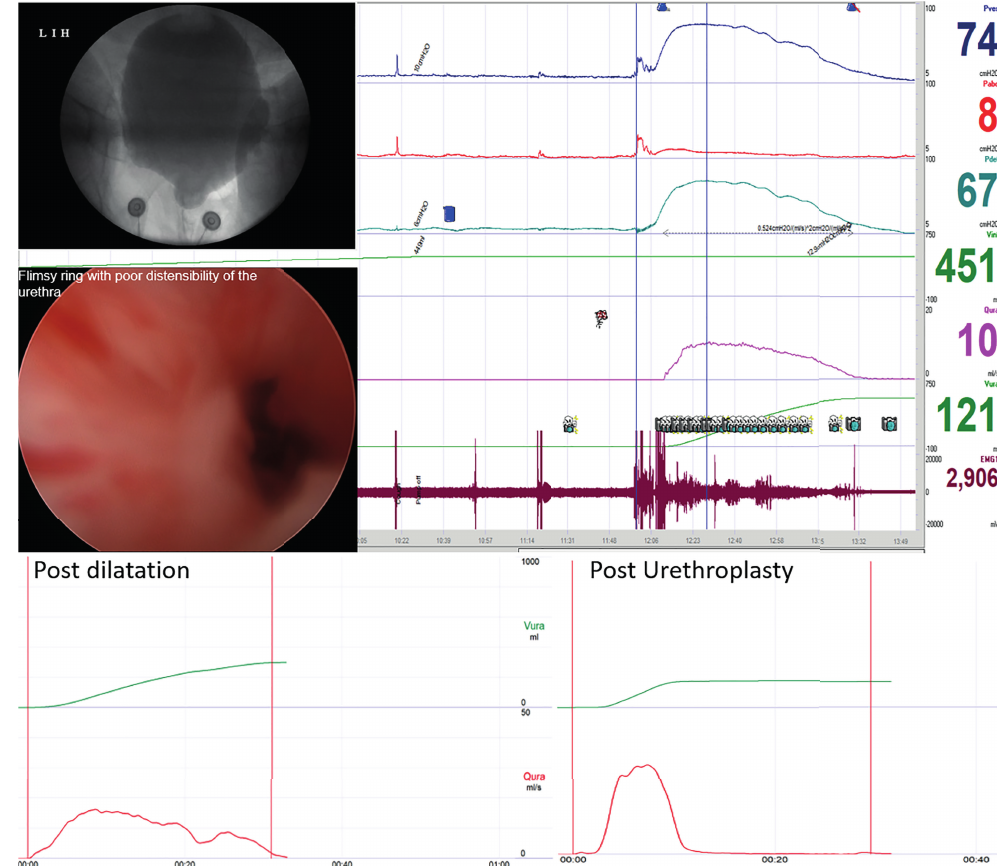
Figure 3 - 43-year-old lady with IPSS (27) with successful calibration with 14F, showing VUDS and urethroscopic correlation with a pDet@Qmax 67cmH2O, fl at fi xed fl ow curve, proximal urethral ballooning, stigmata of stricture as a fl imsy ring with poor distensibility of urethra, Qmax after endodilation~14mL/s and after urethroplasty